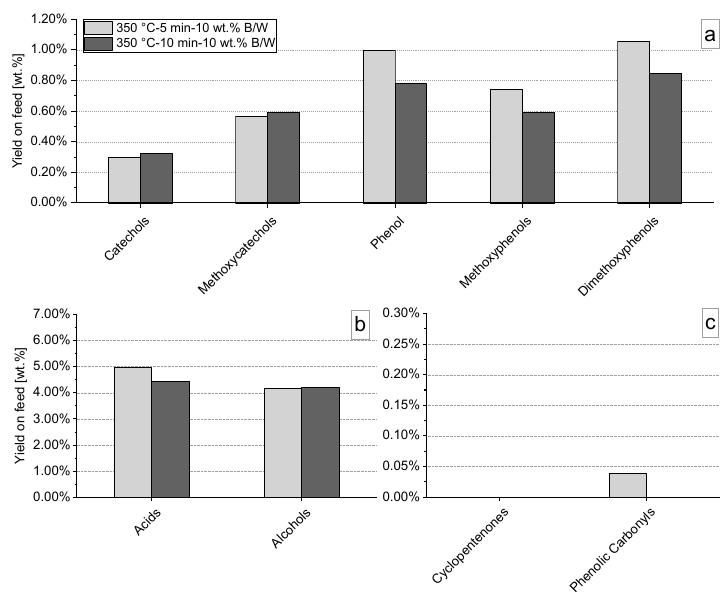
Figure 7. E ff ect of residence time on yields of quantified compounds for uncatalyzed HTL tests: ( a ) phenolics, ( b ) acids and alcohols, ( c ) phenolic carbonyls and cyclopentenones. When no graph column is depicted, the concentration was below quantification limits.